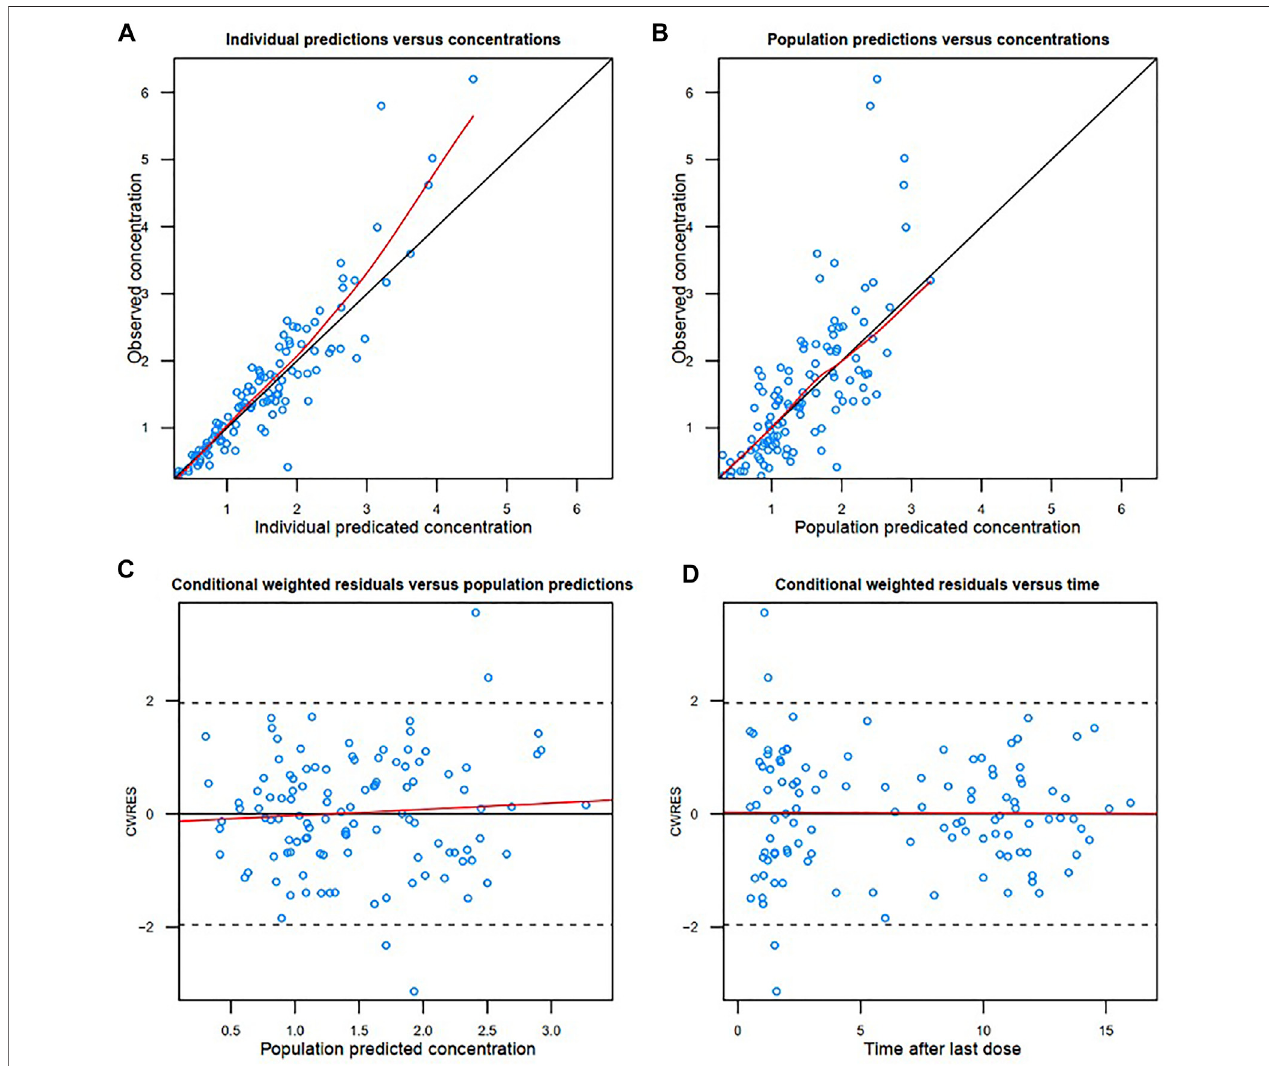
FIGURE 2 | Diagnostic goodness-of- fi t plots of the fi nal model. (A) Observed concentration (DV) vs. individual predicted concentration (IPRED); (B) DV vs. population predicted concentration (PRED); (C) conditional weighted residuals (CWRES) vs. PRED; and (D) CWRES vs. time. The red lines in the upper panel represent loess smooth lines and linear fi t lines, respectively.